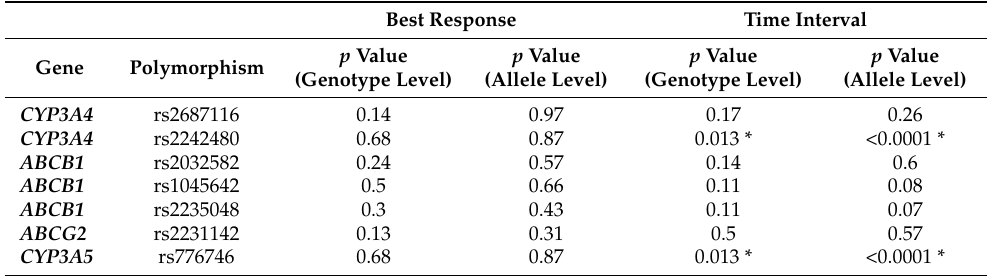
Table 11. p value by chi-squared test at genotype and allele level for best response and interval to reach the best response. Correlation between response to Lenvatinib and polymorphisms linked to MKI